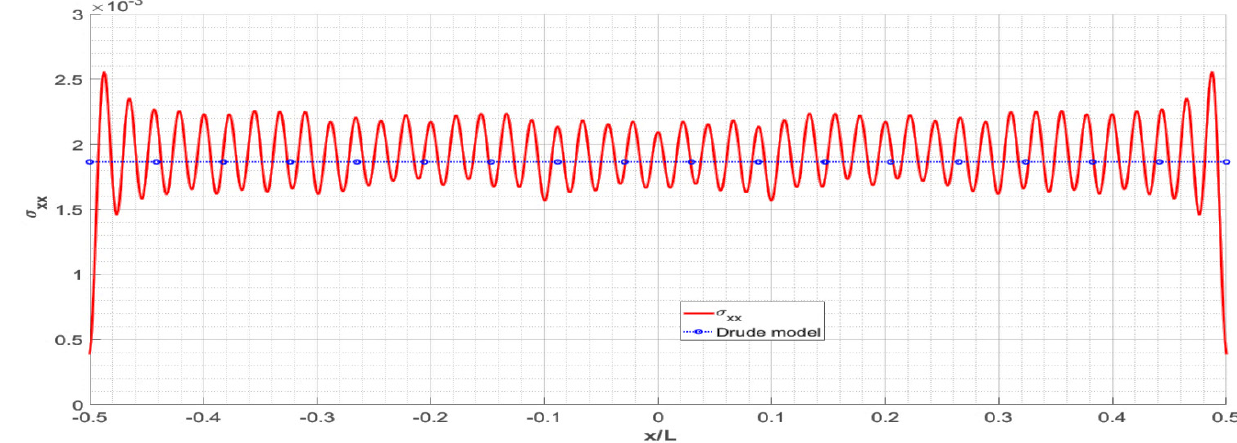
Figure 3. The spatial distribution of the conductance in the units G Drude / Ll . L = 800 nm, µ = 0.1 eV.